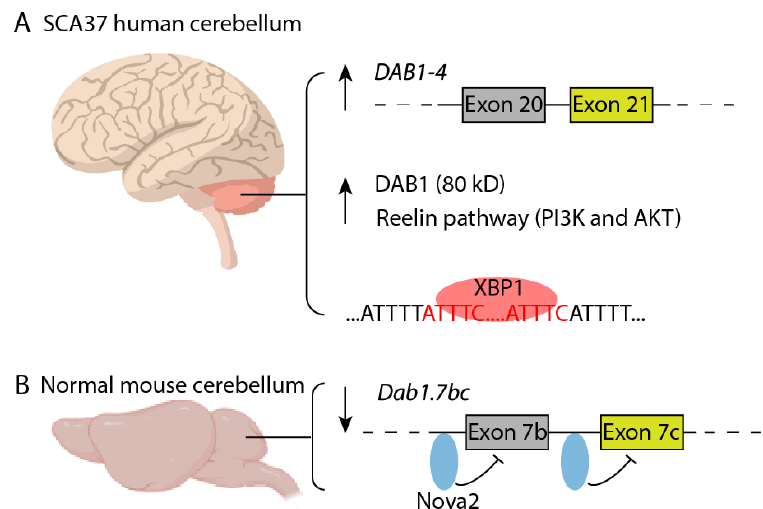
Figure 4. DAB1 mRNA and protein dysregulation in SCA37 brain. ( A ) DAB1-4 mRNA (with exons 20 and 21 inclusion) is uniquely expressed in SCA37 but absent in control cerebellum. DAB1 (80 kD) overexpression and reelin pathway overactivation are observed in SCA37 patient cerebellum. In silico prediction identifies ATTTC repeats as binding sites for XBP1. ( B ) In normal mouse cerebellum, the transcription factor Nova2 binds to the YCAY sites upstream of exons 7b and 7c (evolutionarily conserved and color coded as exons 20 and 21) to prevent their inclusion. Overexpression of Dab1.7bc mRNA antagonizes WT Dab1 function and causes migration defects of Purkinje cells.